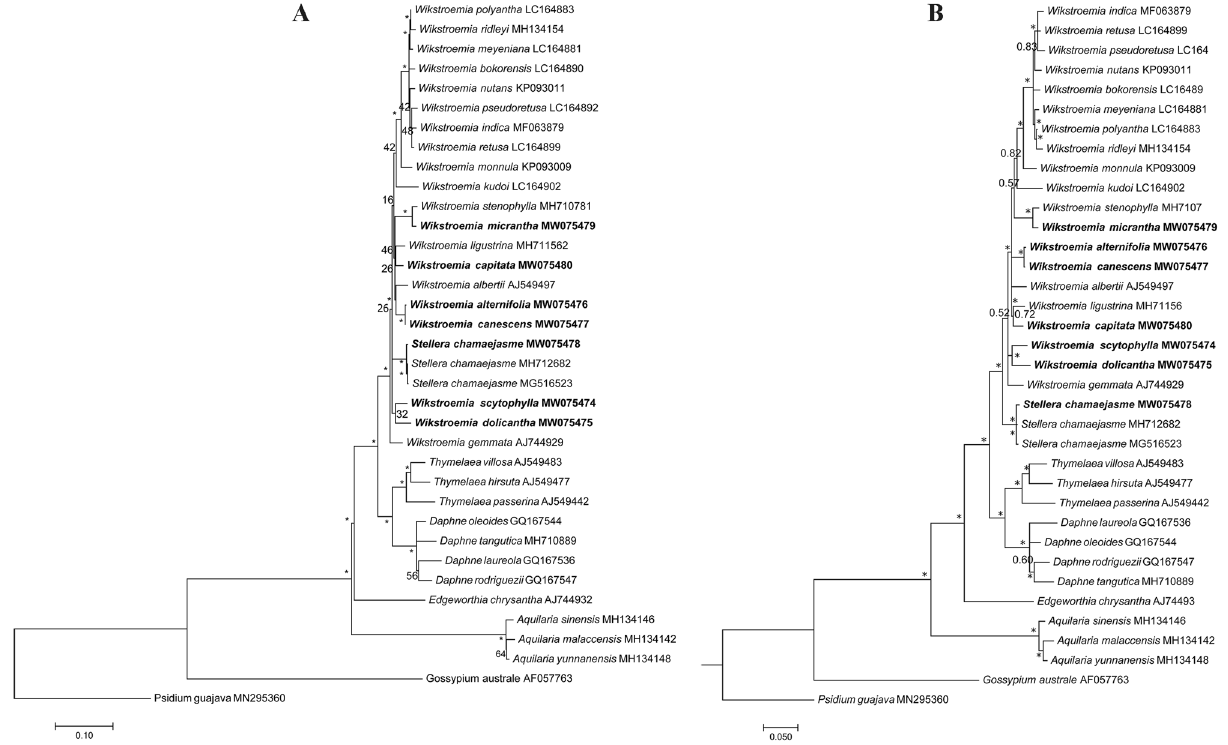
Figure 8. Phylogenetic analyses of Thymelaeaceae based on nuclear ribosomal DNA internal transcribed spacer (ITS) gene sequences of 34 taxa representing 6 genera of Thymelaeaceae. ( A ) Maximum-likelihood (ML) and ( B ) Bayesian inference (BI) tree analyses were conducted with 1000 bootstrap replicates. Branch nodes that were calculated with reliable support values (ML: bootstrap ≥ 75%; BI: posterior probability ≥ 0.90) are indicated with an asterisk (*). Two species, Psidium guajava (MN2953604) and Gossypium australe (AF057763), were included as